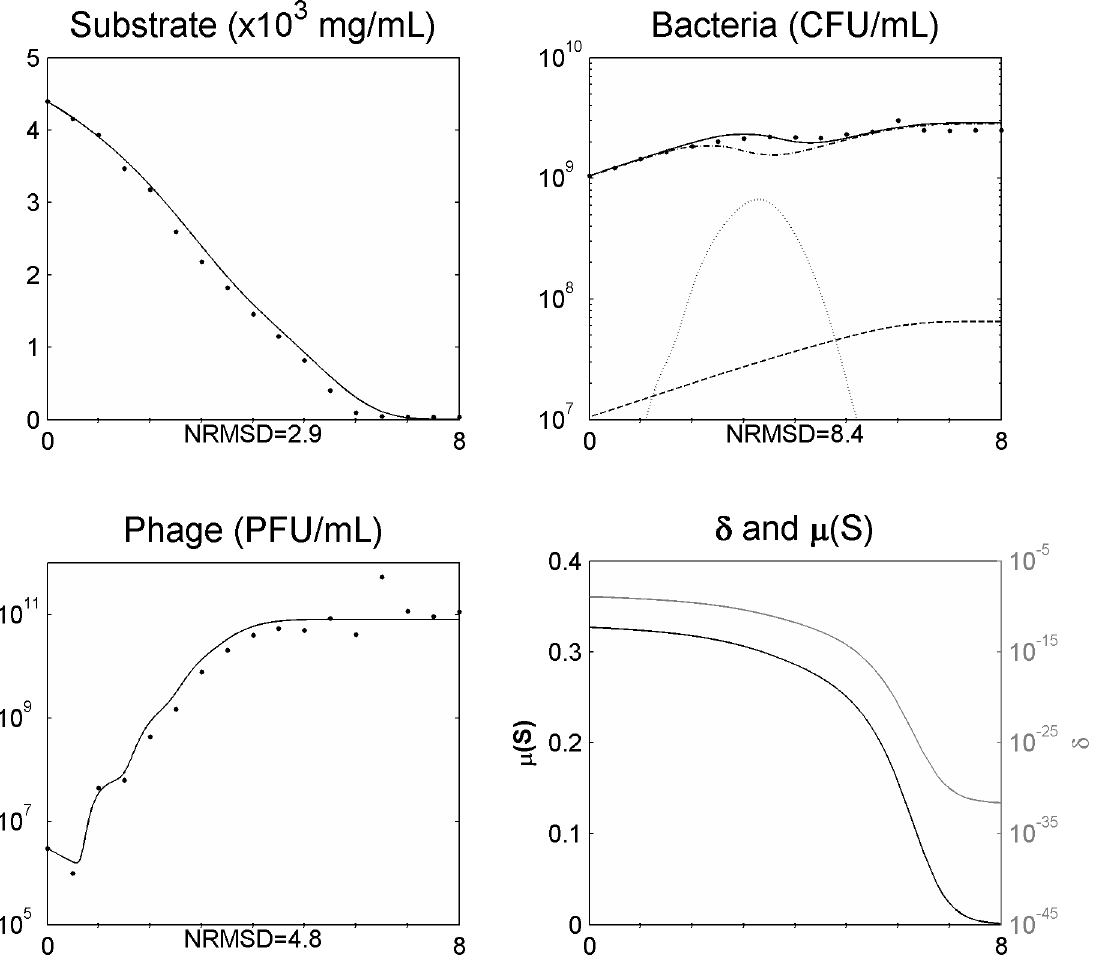
Figure 6. Simulating the phage and bacteria population dynamics using a distribution of values of the latent period and a variation of the adsorption constant ( d ) as a function of the bacterial growth rate ( m ) in a 5 l bioreactor for a MOI=2.8E10 2 3 . Legend: N experimental data; ___ model simulation; - . - model simulation of susceptible uninfected bacteria ( X s ); … model simulation of infected bacteria ( X i ); _ _ model simulation of resistant bacteria ( X r ). The x axis represents time in hours.